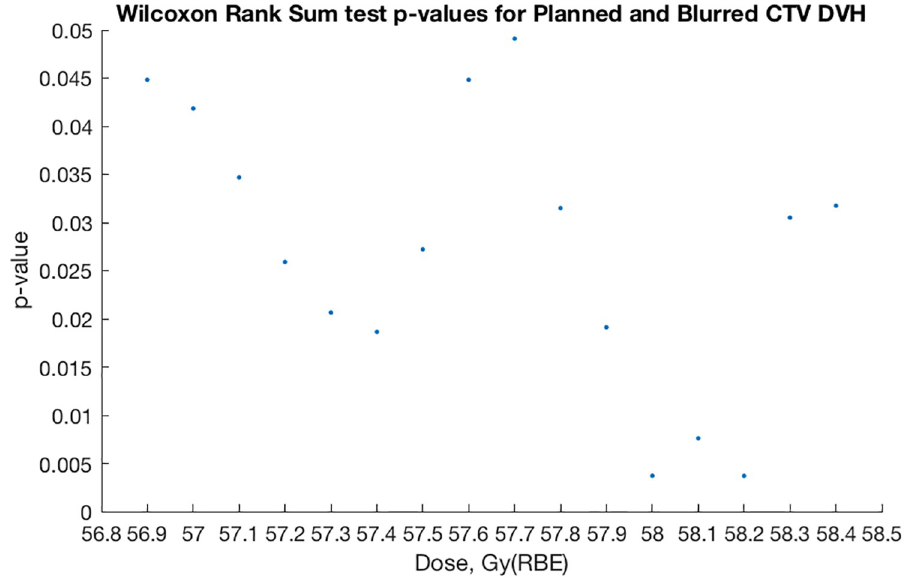
Fig 12. Wilcoxon rank sum test comparing planned and blurred CTV DVH per